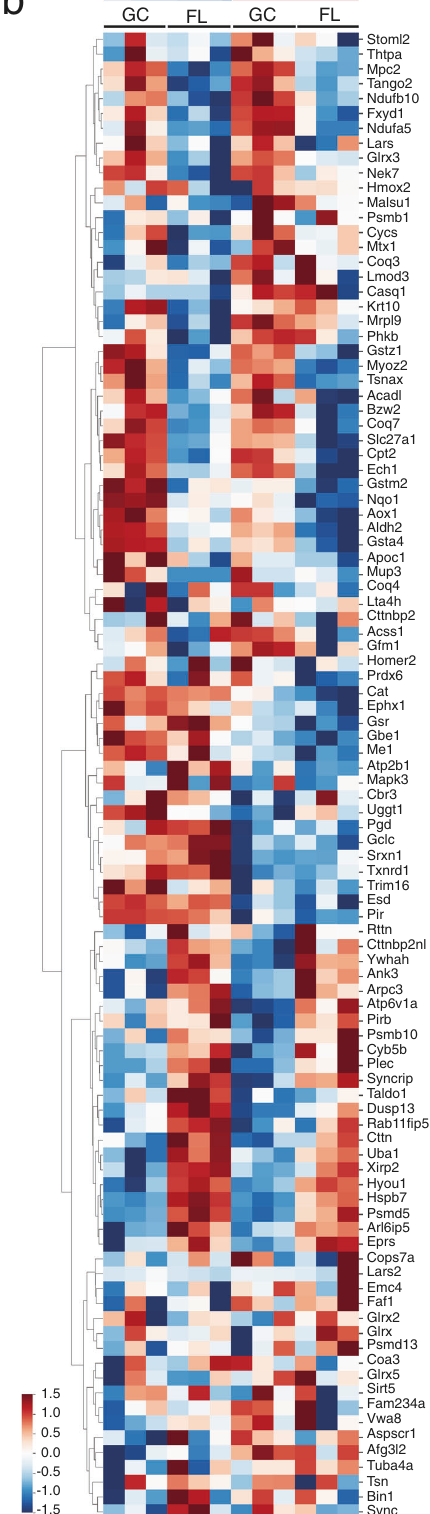
Fig. 4 Pattern of NRF2-target gene expression in soleus muscles. a Expression of Hmox1 and Nqo1 genes in soleus muscles. n = 3 for WT-GC, WT-FL, KO-GC and KO-FL. edgeR test * P < 0.05, ** P < 0.01 (FDR-corrected). b Heatmap depicting the gene expression patterns of upregulated genes in skeletal muscle-speci fi c Keap1- knockout